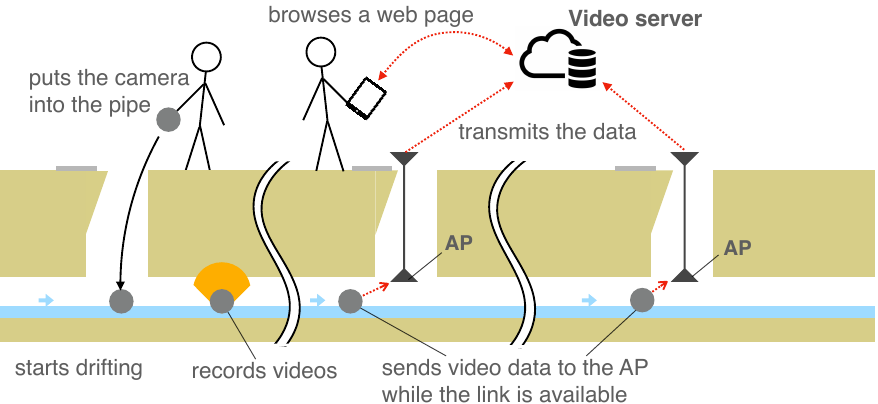
Figure 1. Sewer inspection system using drifting wireless camera nodes: An inspector places the drifting wireless camera nodes (CNs) into the pipe. Then, each CN starts drifting and recording videos inside the sewer pipe. Each CN sends video data to access points (APs) when it is within the wireless communication range of one of the APs. The AP receives the data and forwards the received data to the video server. Users can access the server and identify damaged points of the pipe via web